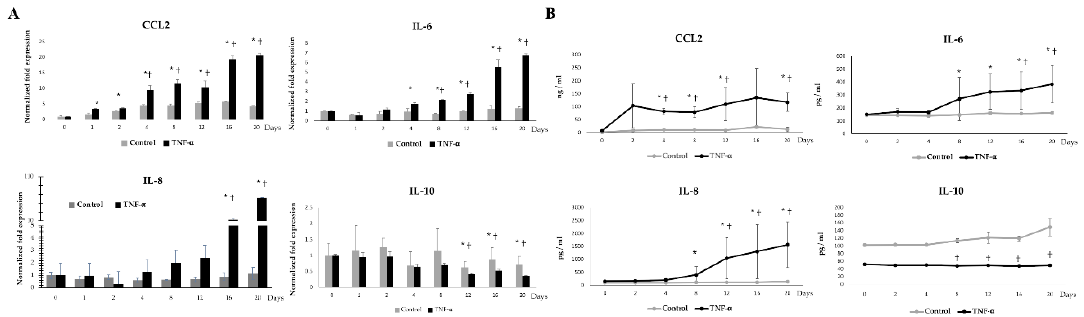
Figure 7. TNF- α mediated adipokine production in adipocytes. The mRNA expressions ( A ) and protein concentration ( B ) of CCL2, IL-6, IL-8, IL-10 in the adipocytes at different time points of 20 days of differentiation. Data shown are the mean ± SD of three independent experiments performed in triplicates. The ‘ * ’ indicated statistical differences when compared with day 0, and ‘†’ indicated statistical differences when compared with control group at the same time point, both at the significance level of p < 0.05.